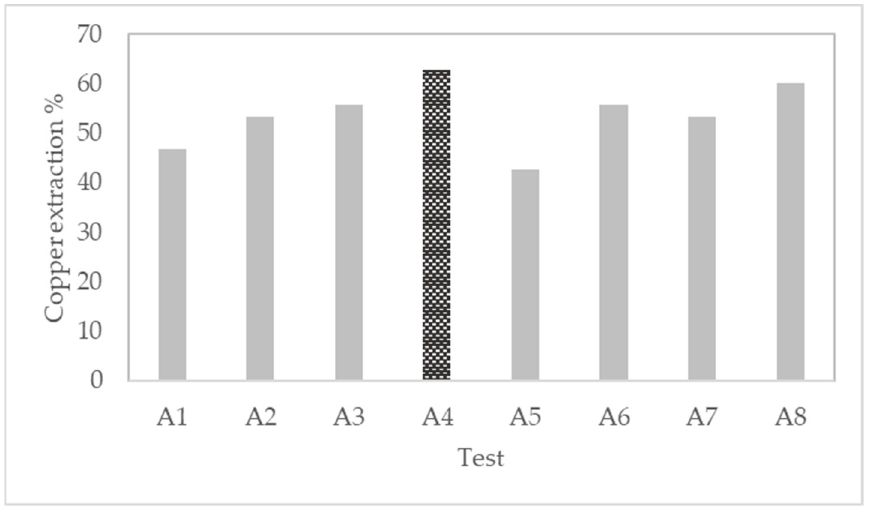
Figure 2. Evaluation of pretreatment conditions in tests A expressed in copper